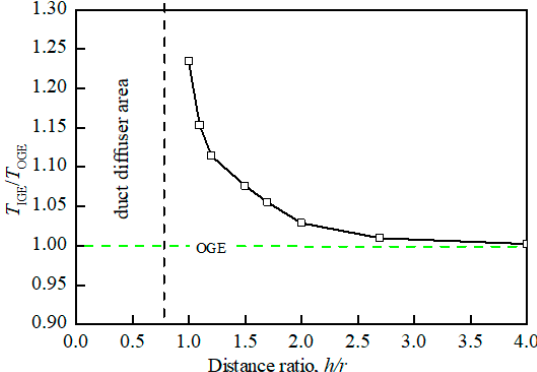
Figure 5. Connection diagram of lift ratio at different distance ratios (ground effect).